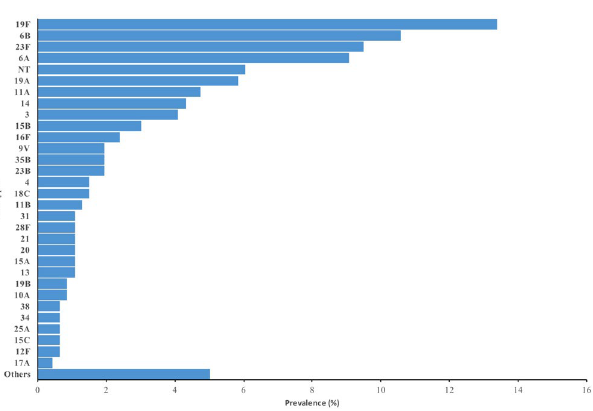
Figure 2. Nasopharyngeal carriage prevalence of individual Pneumococcal serotypes in Pakoto (urban setting), Nigeria.